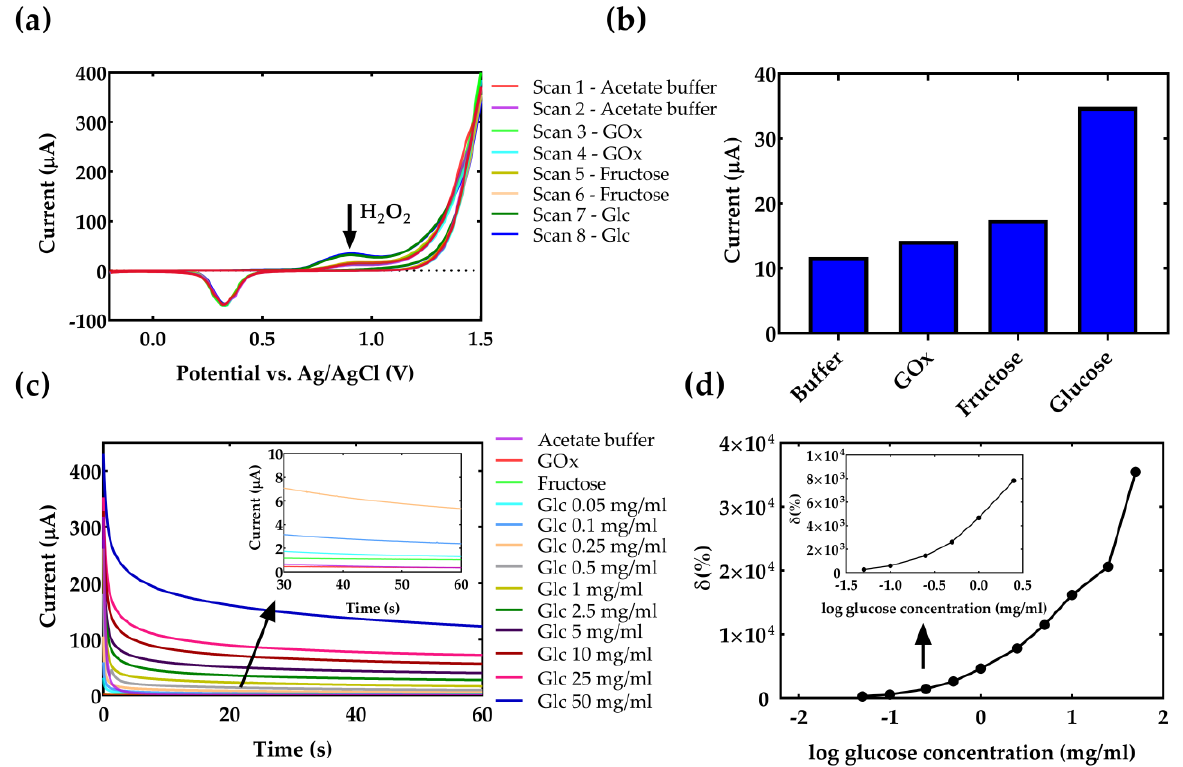
Figure 4. Results of electrochemical Glc detection in the proposed LOC. ( a ) Examining the potential of H 2 O 2 oxidation peak. Scans 1–2 in acetate buffer. Scans 3–4 added droplet of GOx. Scans 5–6 added droplet of fructose. Scans 7–8 added droplet of Glc. ( b ) Intensity of oxidation peaks from Figure 4a at 0.9 V vs. Ag/AgCl. ( c ) Results of chronoamperometry for Glc prepared in acetate buffer. ( d ) Calibration curve of Glc detection in acetate buffer. The signal is presented as a relative change versus acetate buffer response. 𝛿(%) = 100 × (𝐼 𝑐𝑐 − 𝐼 𝑏𝑢𝑓𝑓𝑒𝑟 ) 𝐼 𝑏𝑢𝑓𝑓𝑒𝑟 ⁄ .